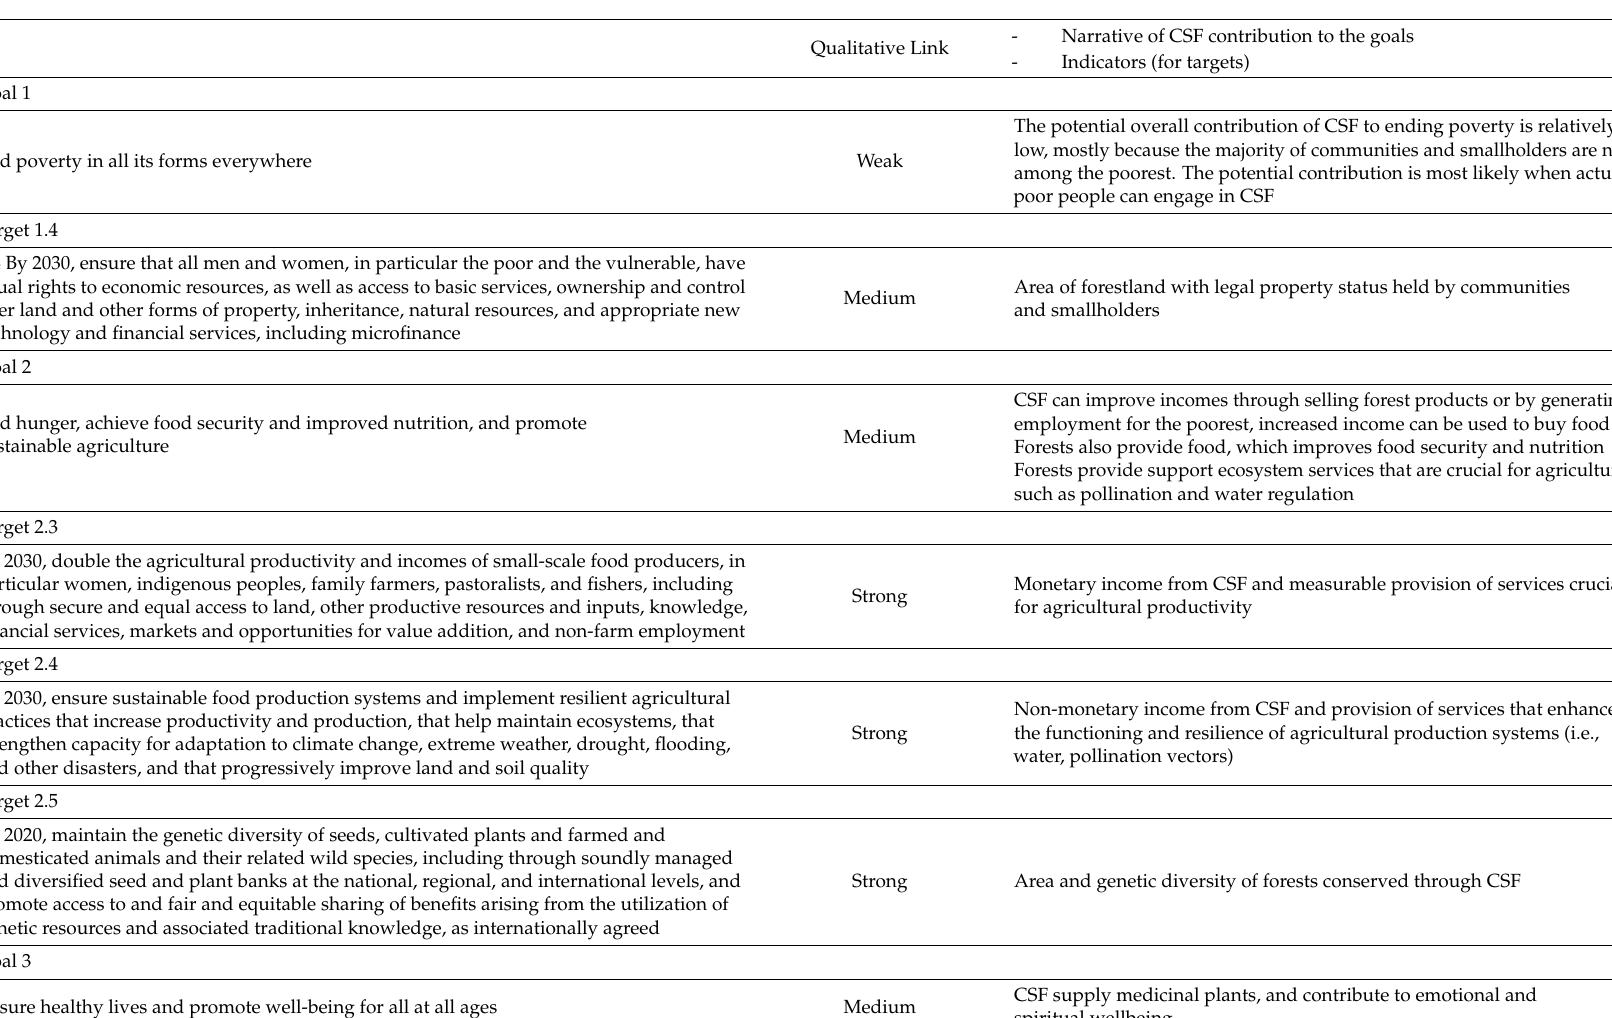
Table 1. SDGs. Targets and their links with community and smallholder